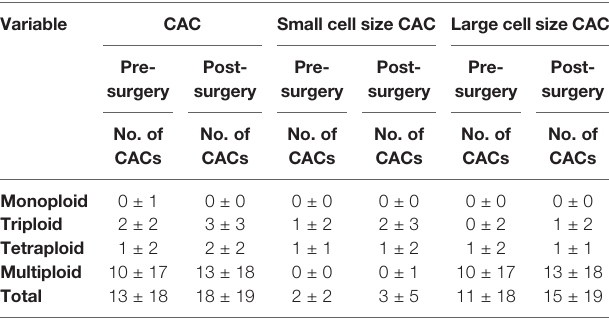
TABLE 6 | Average CAC number in 35 pairs of patients before and after the surgery.